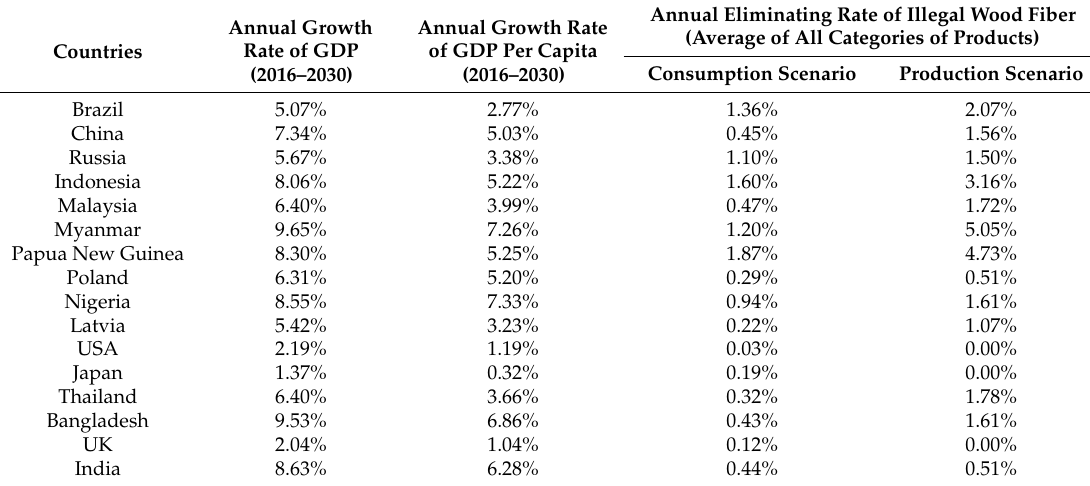
Table 1. Macroeconomics and eliminating rate of illegal wood fiber in the main consuming and producing countries under each